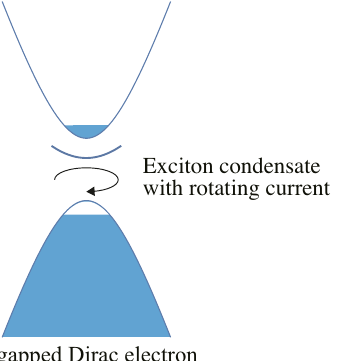
Figure 4 . Chiral exciton BEC in gapped Dirac materials: this (cid:12)gure schematically shows the weak coupling picture of the vector meson Floquet condensate. It is equivalent to the chiral exciton BEC that can be realized in gapped Dirac materials such as bulk topological